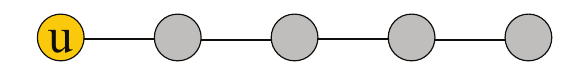
Figure 1. The minimum (maximum) case of closeness value (rank).